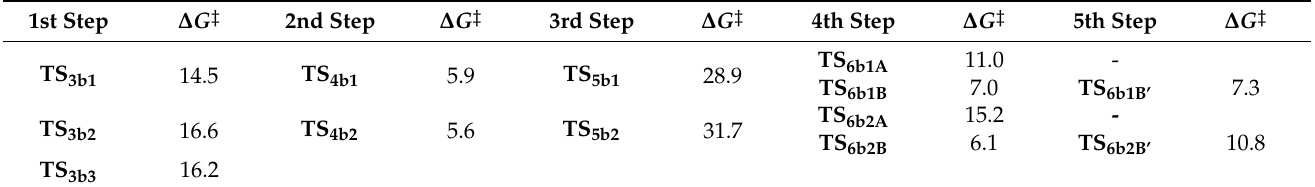
Table 2. Calculated transition states and Gibbs free energies of activation ( Δ G ‡ , in kcal mol − 1 ) for each step of the mechanism between 1,2,4-oxadiazoles and ynamide MeN(Ms)C ≡ CPh.